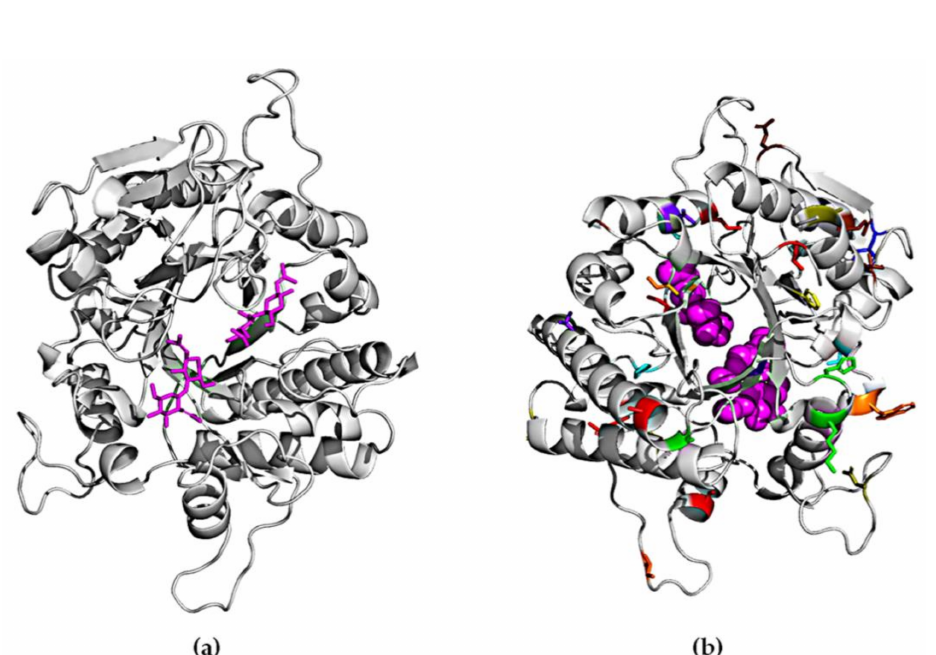
Figure 6. Backbone diagrams of chitinase. ( a ) Chitin substrate highlighted in the active site. ( b ) Mutations are represented by different colors corresponding to those in Table